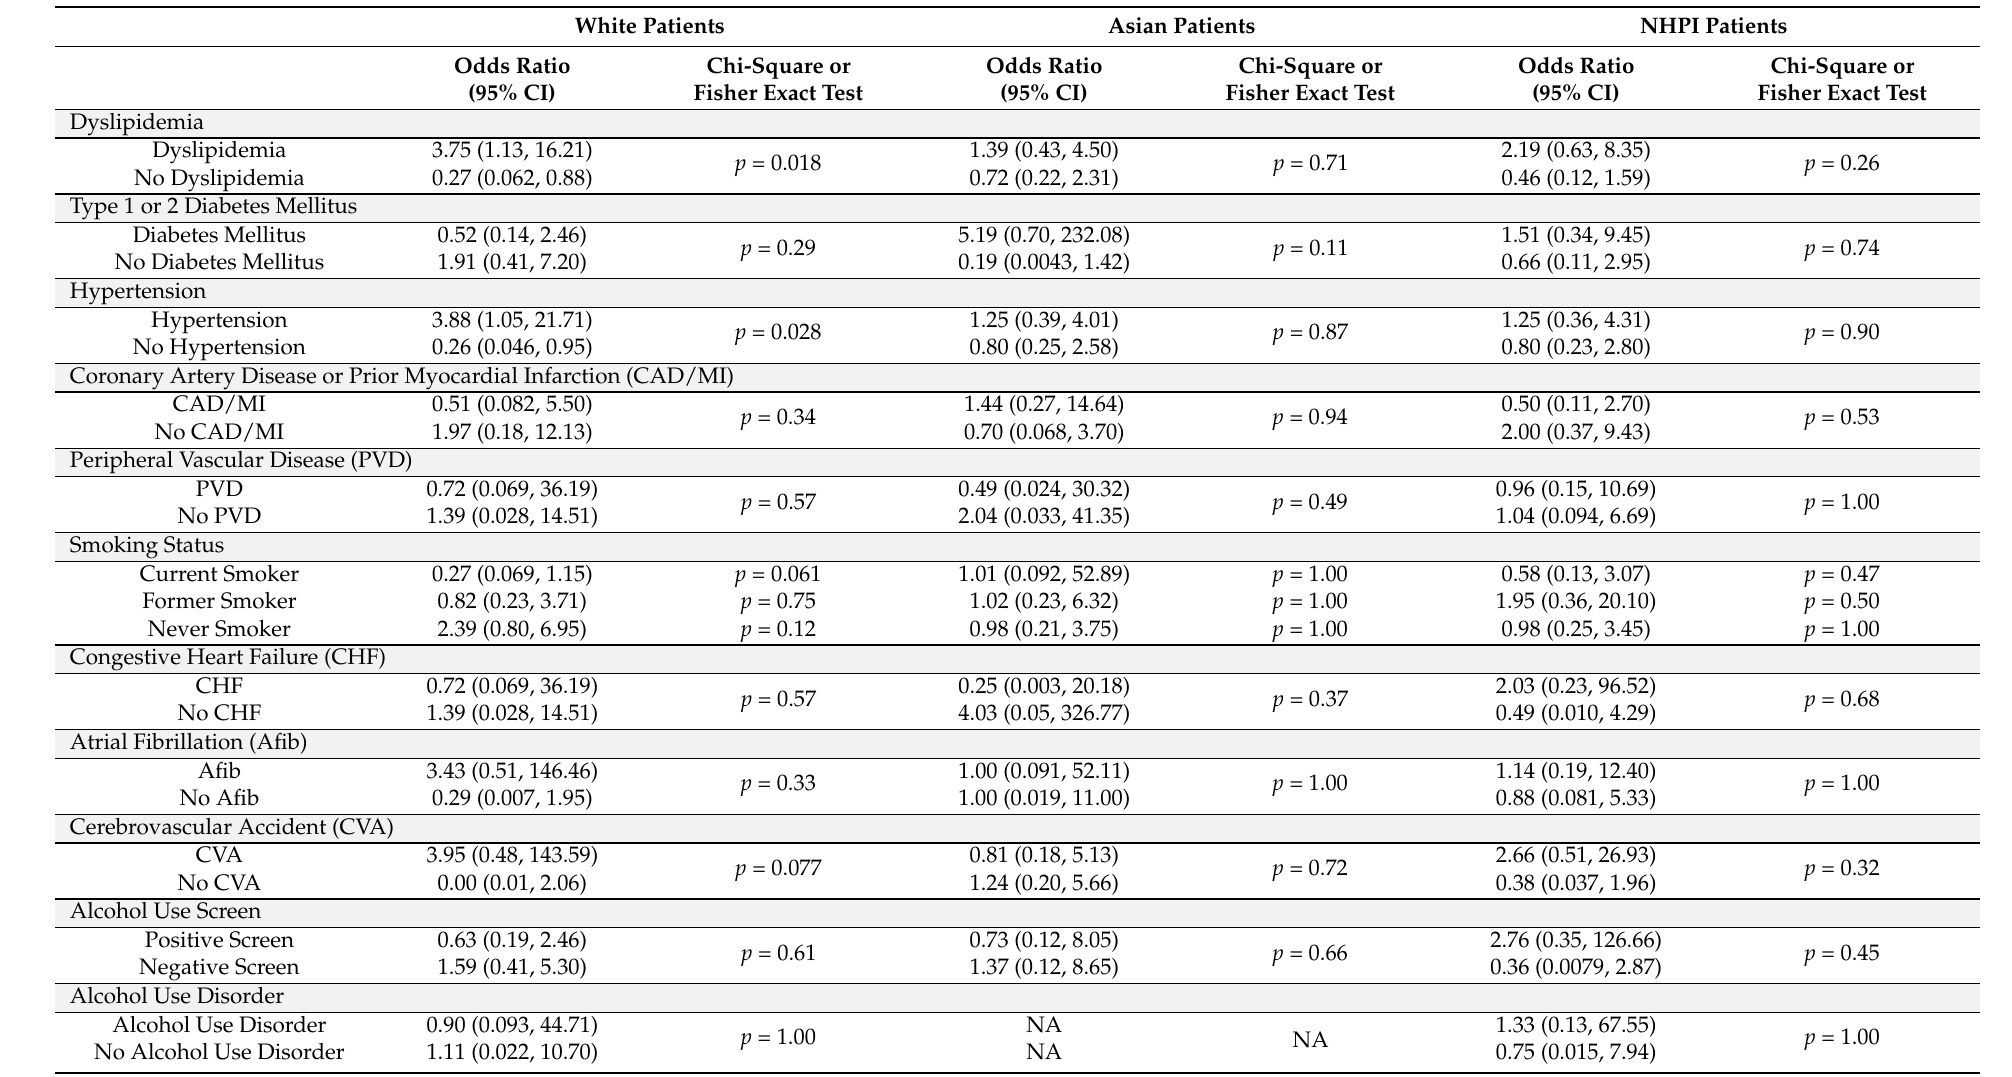
Table 7. Crude odds of vaccination by medical comorbidity stratified by